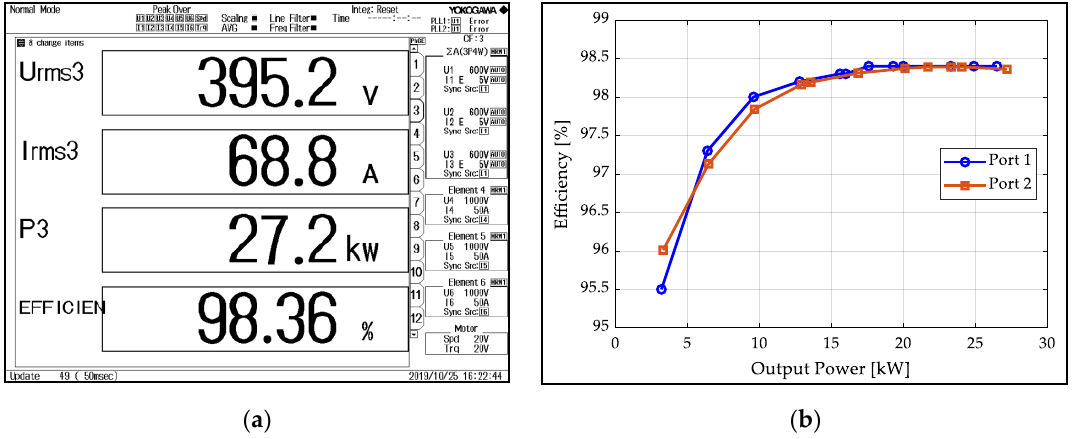
Figure 15. ( a ) IBC efficiency measured from YOKOGAWA power analyzer; ( b ) efficiency of two ports (V in = 250 V, V O = 395 V) with 2% error band of sensors and measuring.